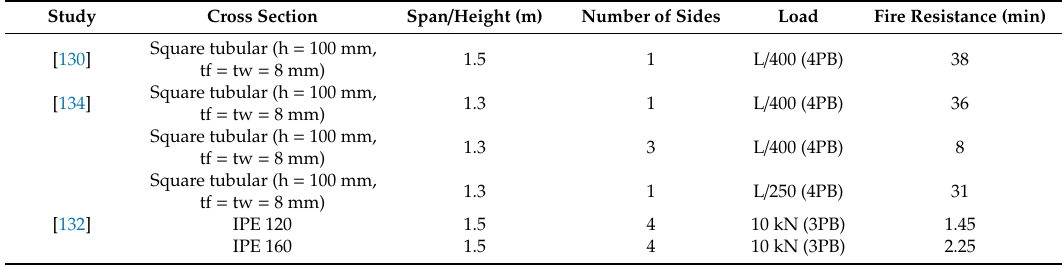
Table 6. Pultruded GFRP beams performance subjected to ISO 834 fire